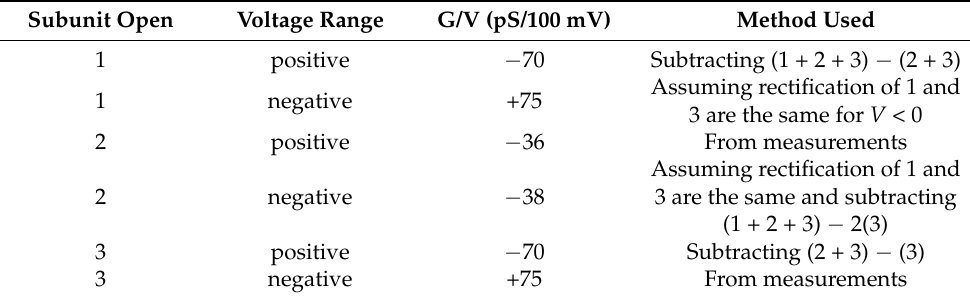
Table 4. Rectification of individual